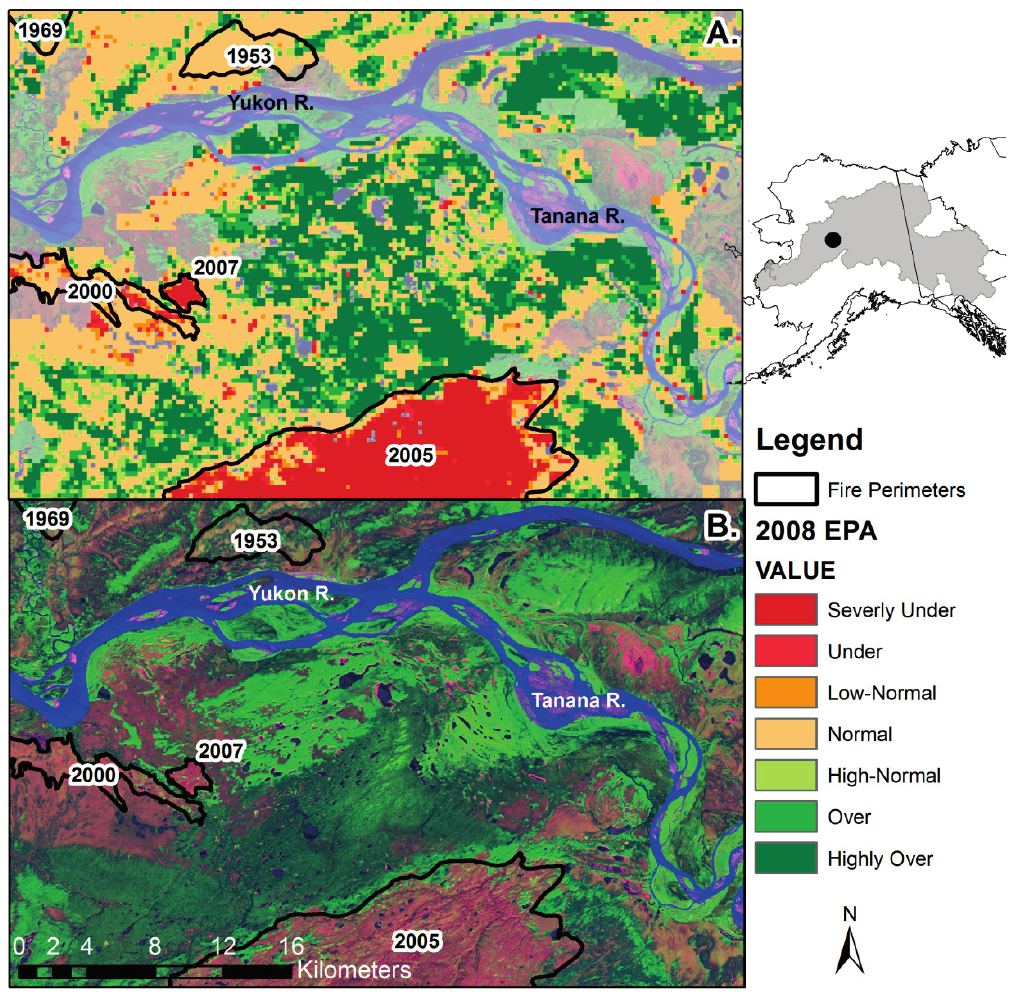
Figure 3. ( A ) 2008 Ecosystem Performance Anomaly (EPA) for a region surrounding the confluence of the Yukon and Tanana Rivers. Location indicated by the black circle in the Yukon River Basin (grey). Fire perimeters (1950–2008) are labeled with the year of burn. ( B ) July–September 2008–2011 composite (Bands: 5, 4, 3) of WELD Landsat imagery. Darker green corresponds to coniferous forest, lime green to deciduous forest, and pink-brown to shrub/herbaceous/woody